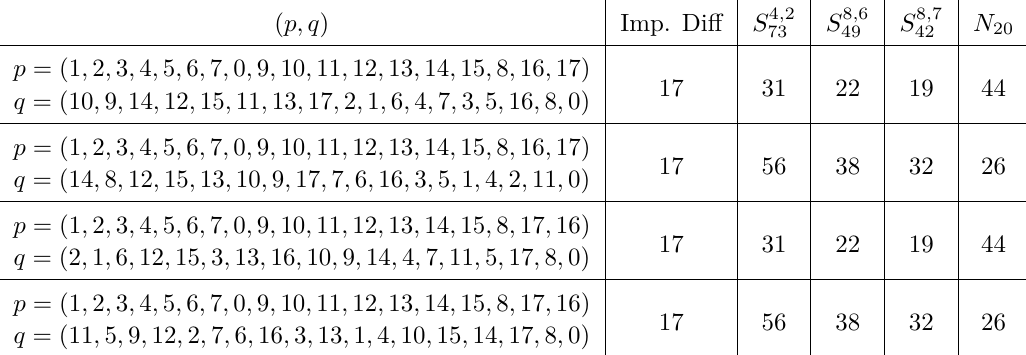
Table 7: Security evaluation for the best equivalence classes with k = 18 ( p, q ) Imp. Diff S 4 , 2